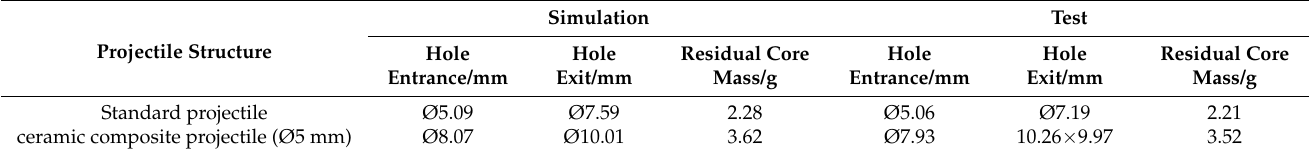
Table 3. Test and simulation data of projectiles with different structures penetrating a 10 mm RHA.